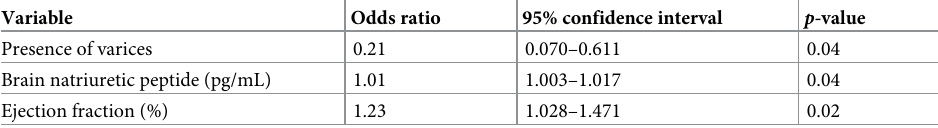
Table 2. Predictors of an RVSP � 36